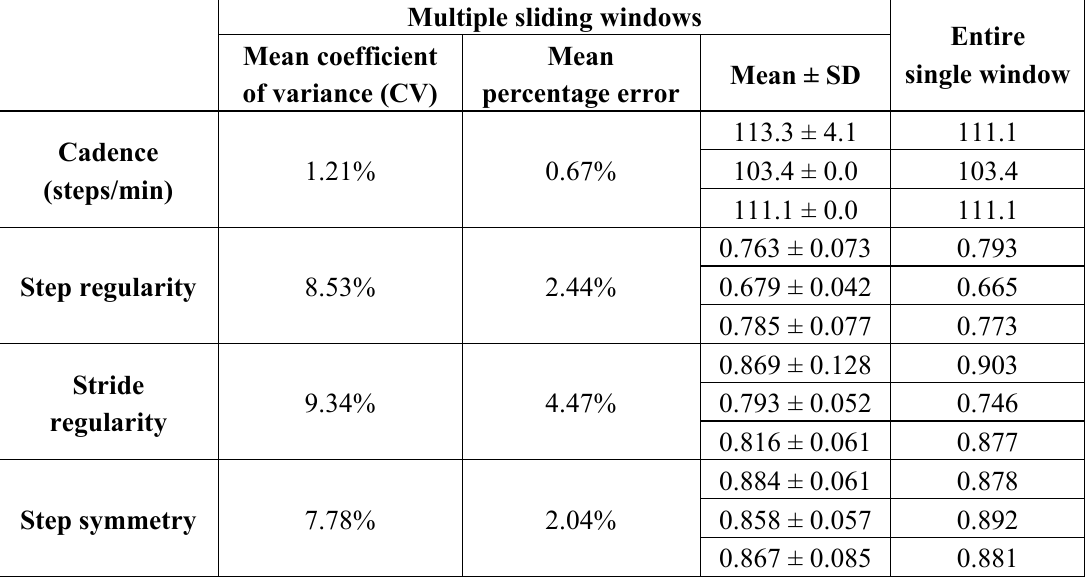
Table 2. Gait cycle parameters derived from multiple sliding windows and the entire single